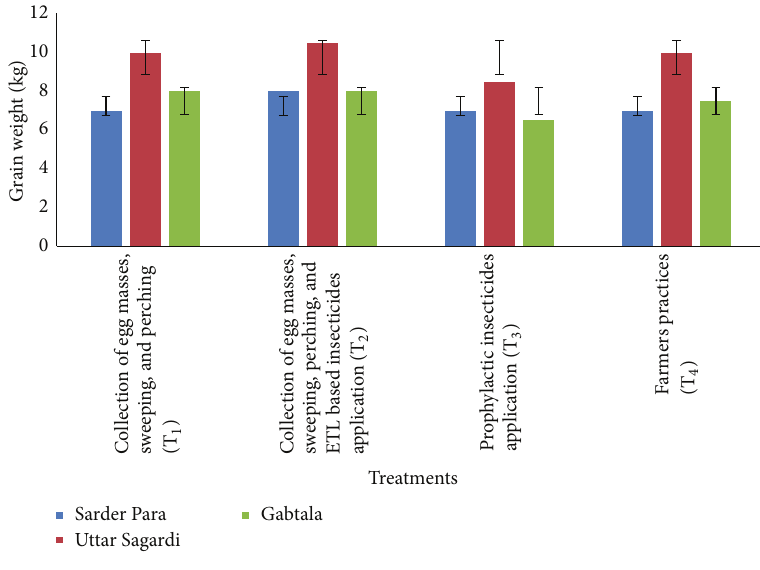
Figure 6: Average grain